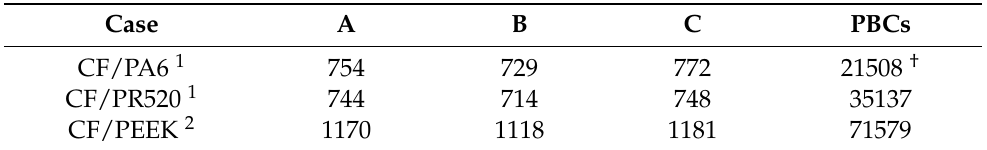
Table 1. Comparison of CPU time (4 CPUs) in second using different cases for RVE model with 4 fibres.